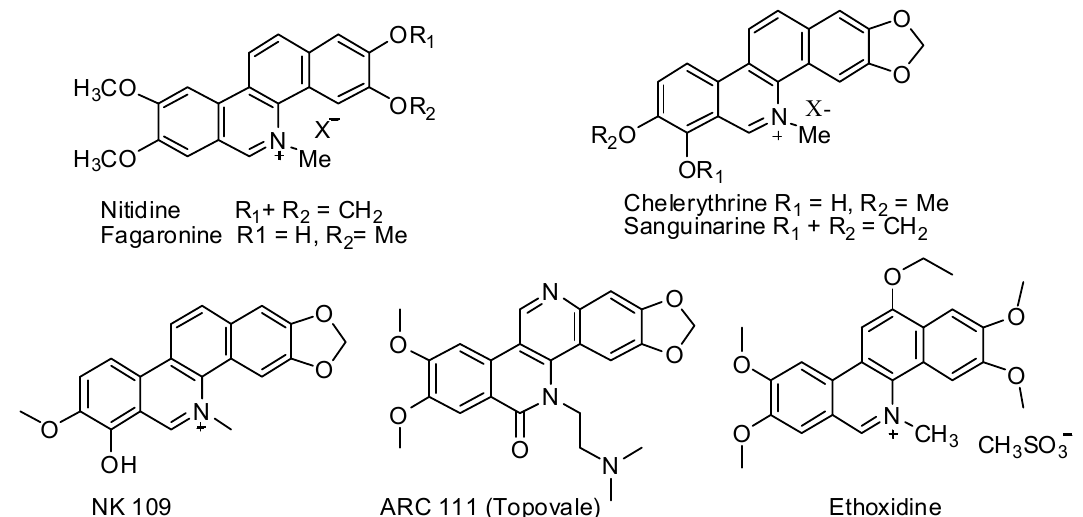
Figure 1. Chemical structures of benzo[ c ]phenanthridine